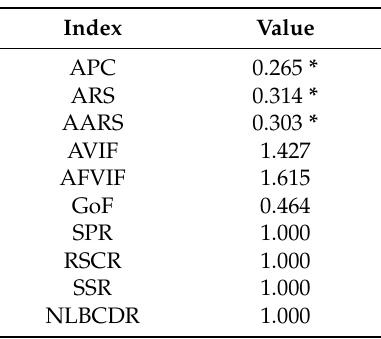
Table 7. Model fit and quality